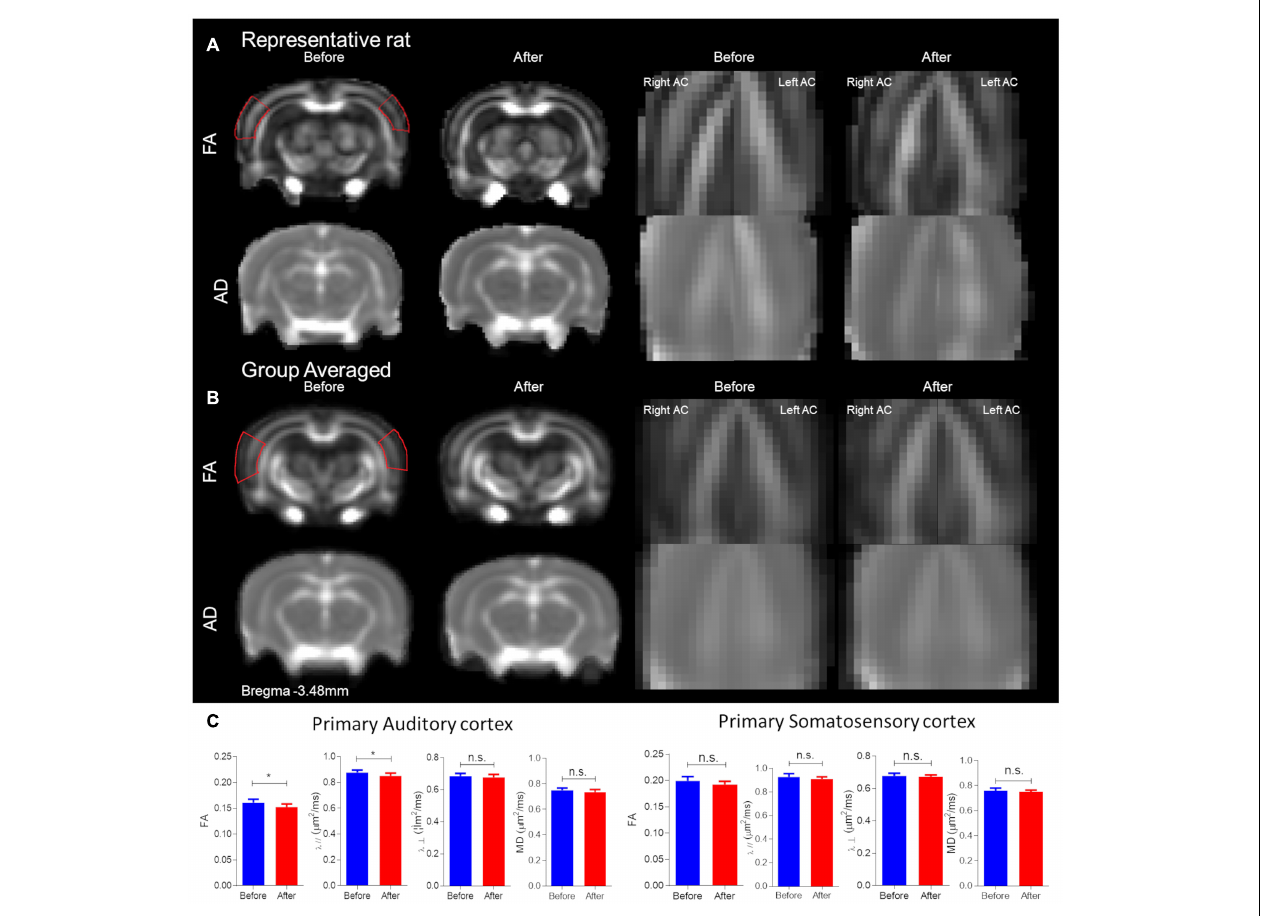
FIGURE 3 | Structural alterations underlying conductive hearing loss assessed by DTI ROIs. The panel is segregated into before and after CHL for Bregma –3.48 mm. (A) Representative rat FA maps (first row of brains from left) and AD maps (second row of brains from left) from individual CHL rats. (B) Group-averaged FA (first row of brains from left) and AD (second row of brains from left) maps for CHL. Note the red outline for FA represents the approximate ROI for measures. (C) Bar plots of DTI measures for the primary auditory cortex and somatosensory cortex: FA, MD, RD ( λ ⊥ ), and AD ( λ // ) for before (blue) and after (red) CHL with standard deviation. The mean FA and AD after CHL were significantly decreased compared to before, T -test: t = 2.769, df = 12, p = 0.0143 and t = 2.474, df = 15, and p = 0.0258, respectively. The asterisk (*) indicates significant p <